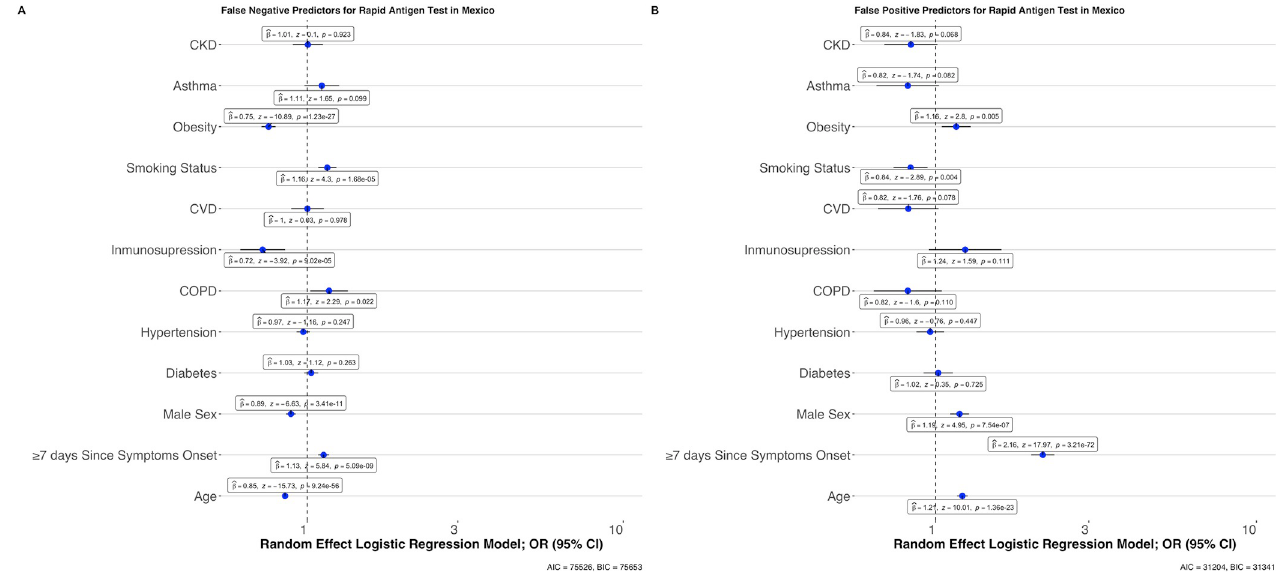
Fig 2. Mixed effects logistic regression models assessing predictors of cases with false negative compared to true positive test results (A) and false positive compared to true negative test results (B) using qRT-PCR as reference tests. Abbreviations: qRT-PCR: Reverse transcription polymerase chain reaction; CKD, Chronic Kidney Disease; CVD: cardiovascular disease; COPD: Chronic Obstructive Pulmonary Disease; OR: Odds Ratio; 95%CI: 95% Confidence interval, ICU: Intensive Care